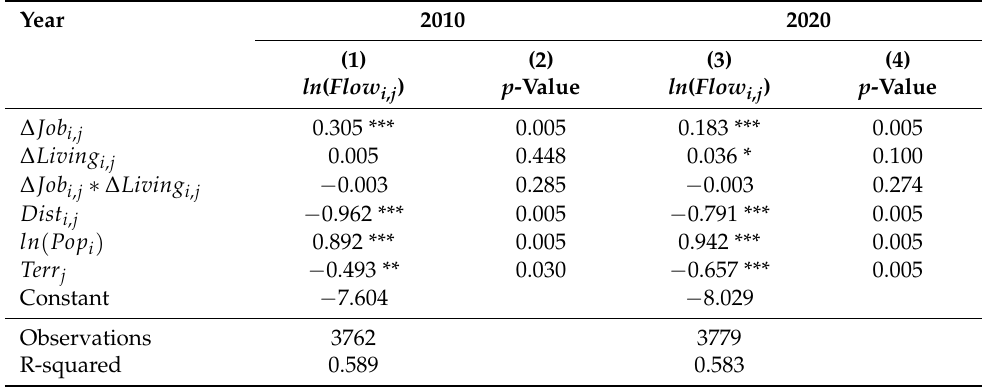
Table 5. The robust regression results of model (2) by the QAP